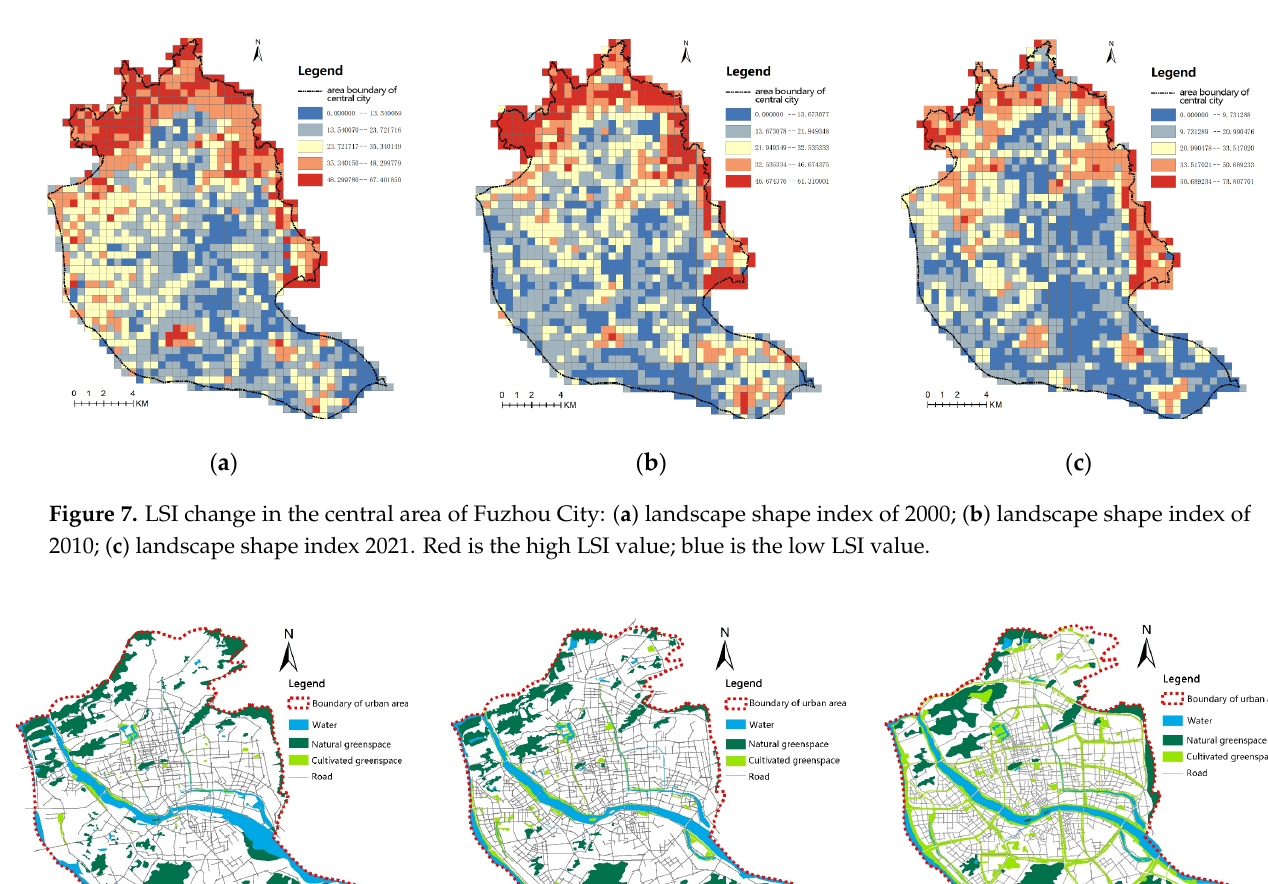
Figure 8. Green space of Fuzhou: ( a ) green space in 2000; ( b ) green space in 2010; ( c ) green space in 2021.